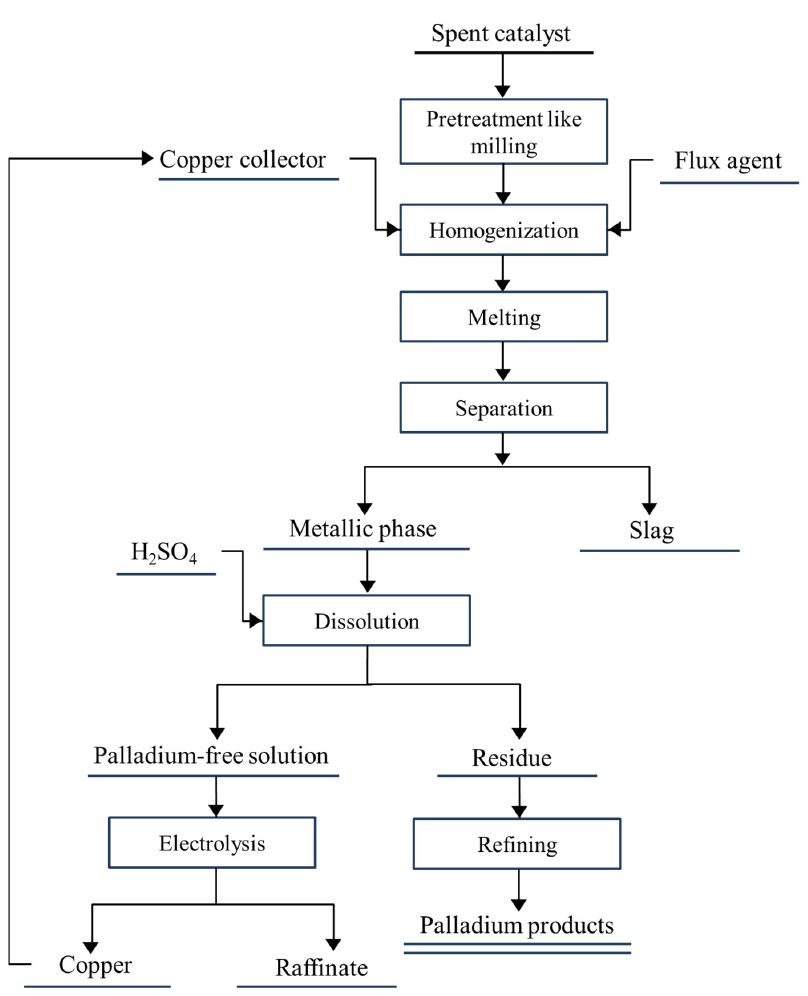
Figure 5. The flowchart of copper capture for recovering PGMs from spent catalysts.